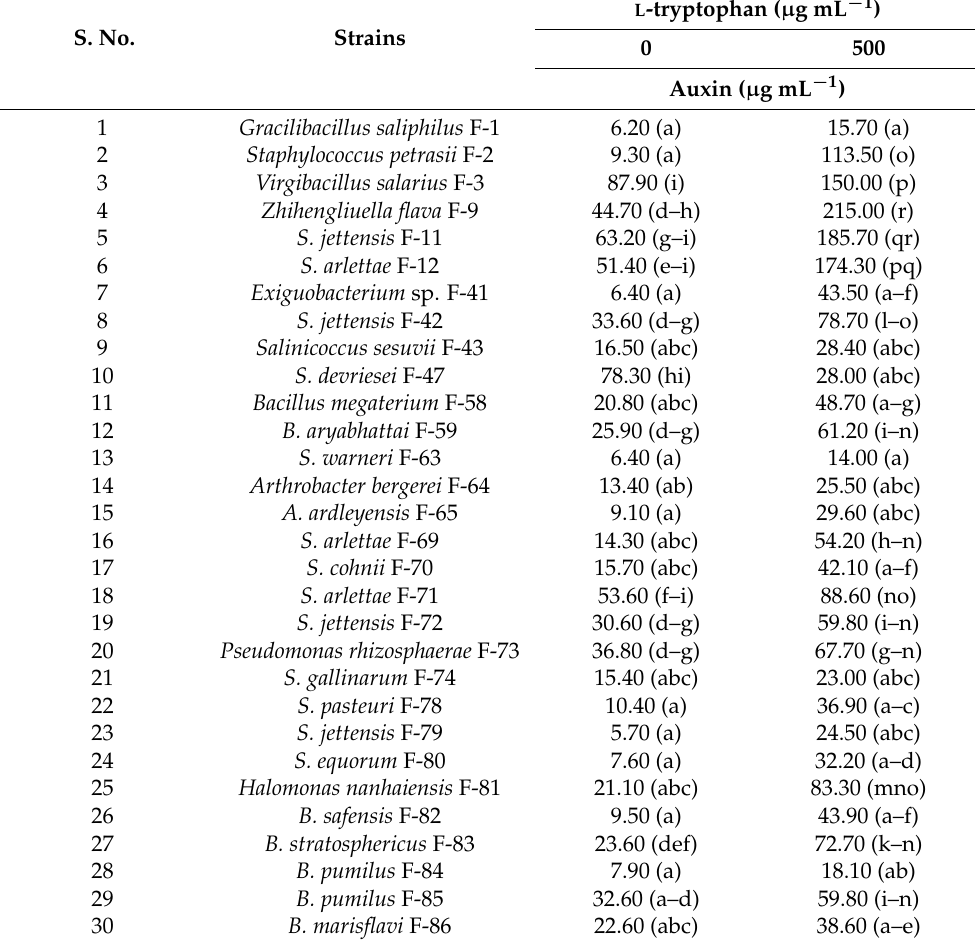
Mean of three replicates. Different letters followed by numerical values within same column indicate significant difference between treatments using Duncan’s multiple range test ( p ≤ 0.05).